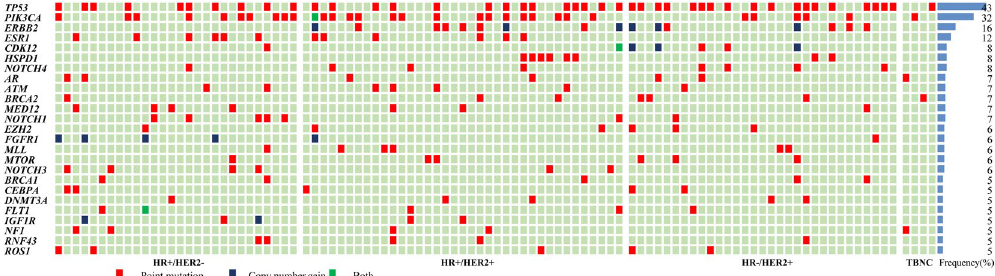
Figure 1. The landscape of hotspot mutations in advanced breast cancer. Each of the 25 hotspot gene mutations has been identified in more than 5 patients listed to the left of the figure. The number of mutations in each gene among the 100 patients is shown (rows). Point mutations, copy number changes and both are colored red, blue and purple, respectively.